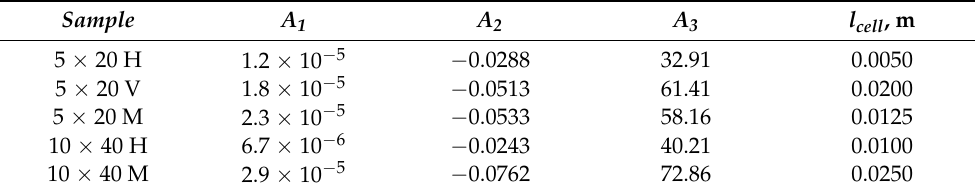
Table 1. Values of the coefficients A 1 –A 3 from Equation (21) and characteristic dimension of the elementary cell l cell obtained for particular